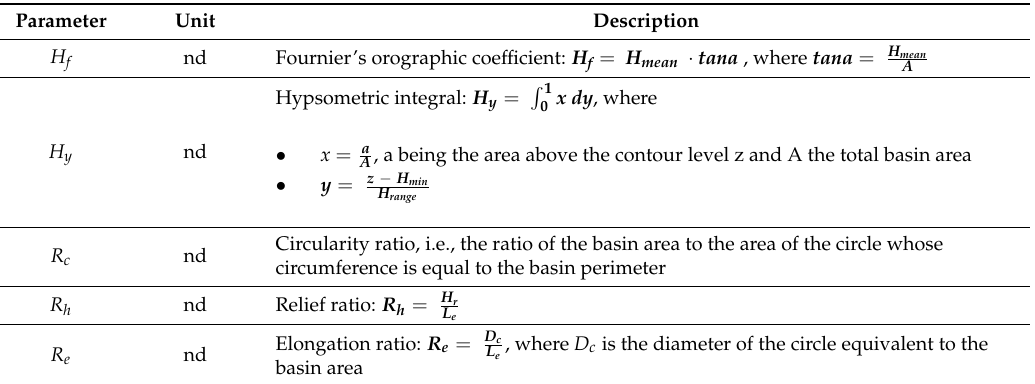
Table A4. Parameters describing the catchment relief and shape.